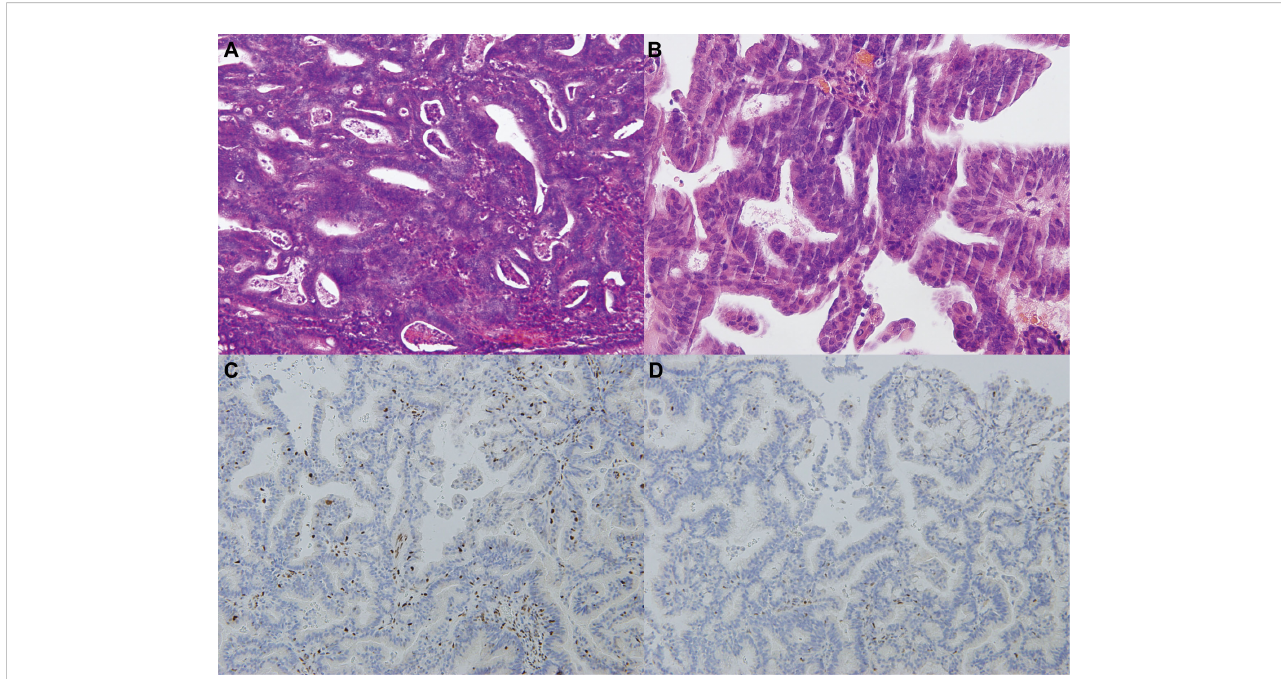
FIGURE 3 Histopathological images of endometrial and colon carcinomas. (A) The HE staining of colonic mass tissue in the descended colon (the microscope magnifying×400). (B) The HE staining of polypoid tissue in the lower uterine segment (the microscope magnifying×400). (C-D) The IHC staining of polypoid tissue in the lower uterine segment (the microscope magnifying×400). MLH1 and PMS2 proteins were negative expression in the IHC staining.